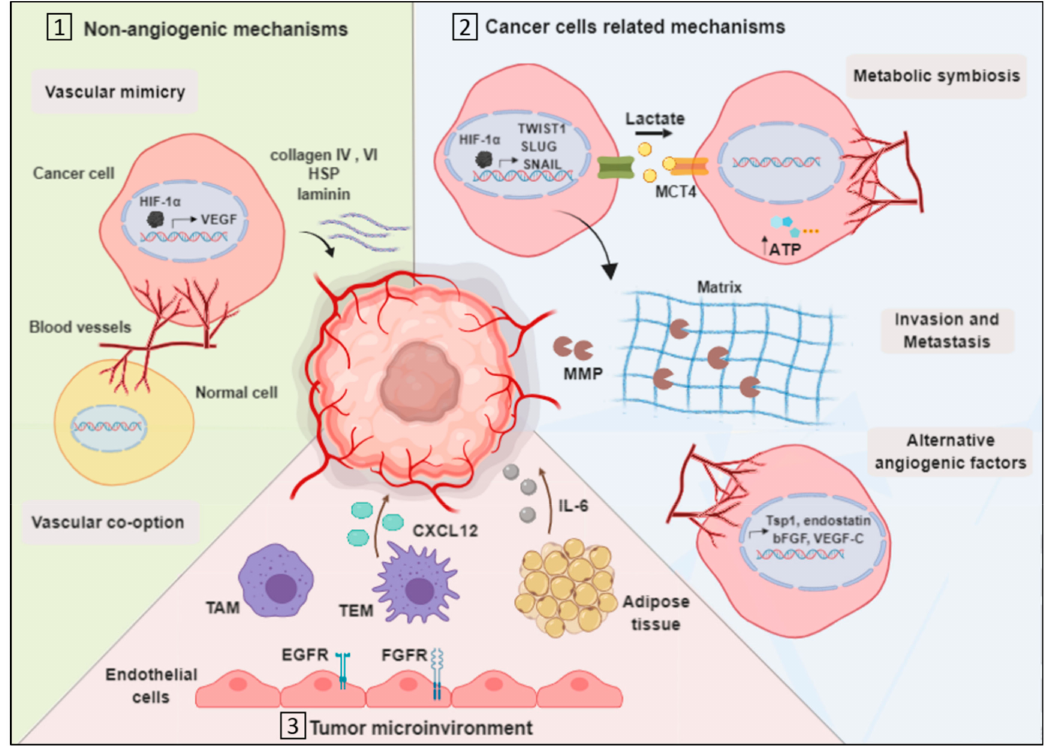
Figure 1. Mechanisms of resistance to anti-angiogenesis therapy. Tumor cells exhibit di ff erent mechanisms to resist anti-angiogenic therapy as ( 1 ) utilizing non-angiogenic mechanisms. In vascular mimicry, cancer cells form tubular structure supported by the secreted matrix proteins as collagen IV and VI, HSP, and laminin. In addition, in vascular co-option process, tumor cells take over existing vascular beds from adjacent normal tissues. ( 2 ) Cancer cell-related mechanisms to resist anti-angiogenic therapy include metabolic symbiosis, in which tumor cells generate adenosine triphosphate (ATP) by using lactate from other tumor cells that su ff er from hypoxia, ultimately supporting vessels formation. Invasion contributes to resistance through the upregulation of extracellular matrix-related factors as MMP. The upregulated expression of alternative angiogenic factors is as well associated with resistance. ( 3 ) Tumor microenvironment-related mechanisms include the participation of the tumor stromal cells such as endothelial cells, TAM, TEM and myeloid and adipose cells in mediating